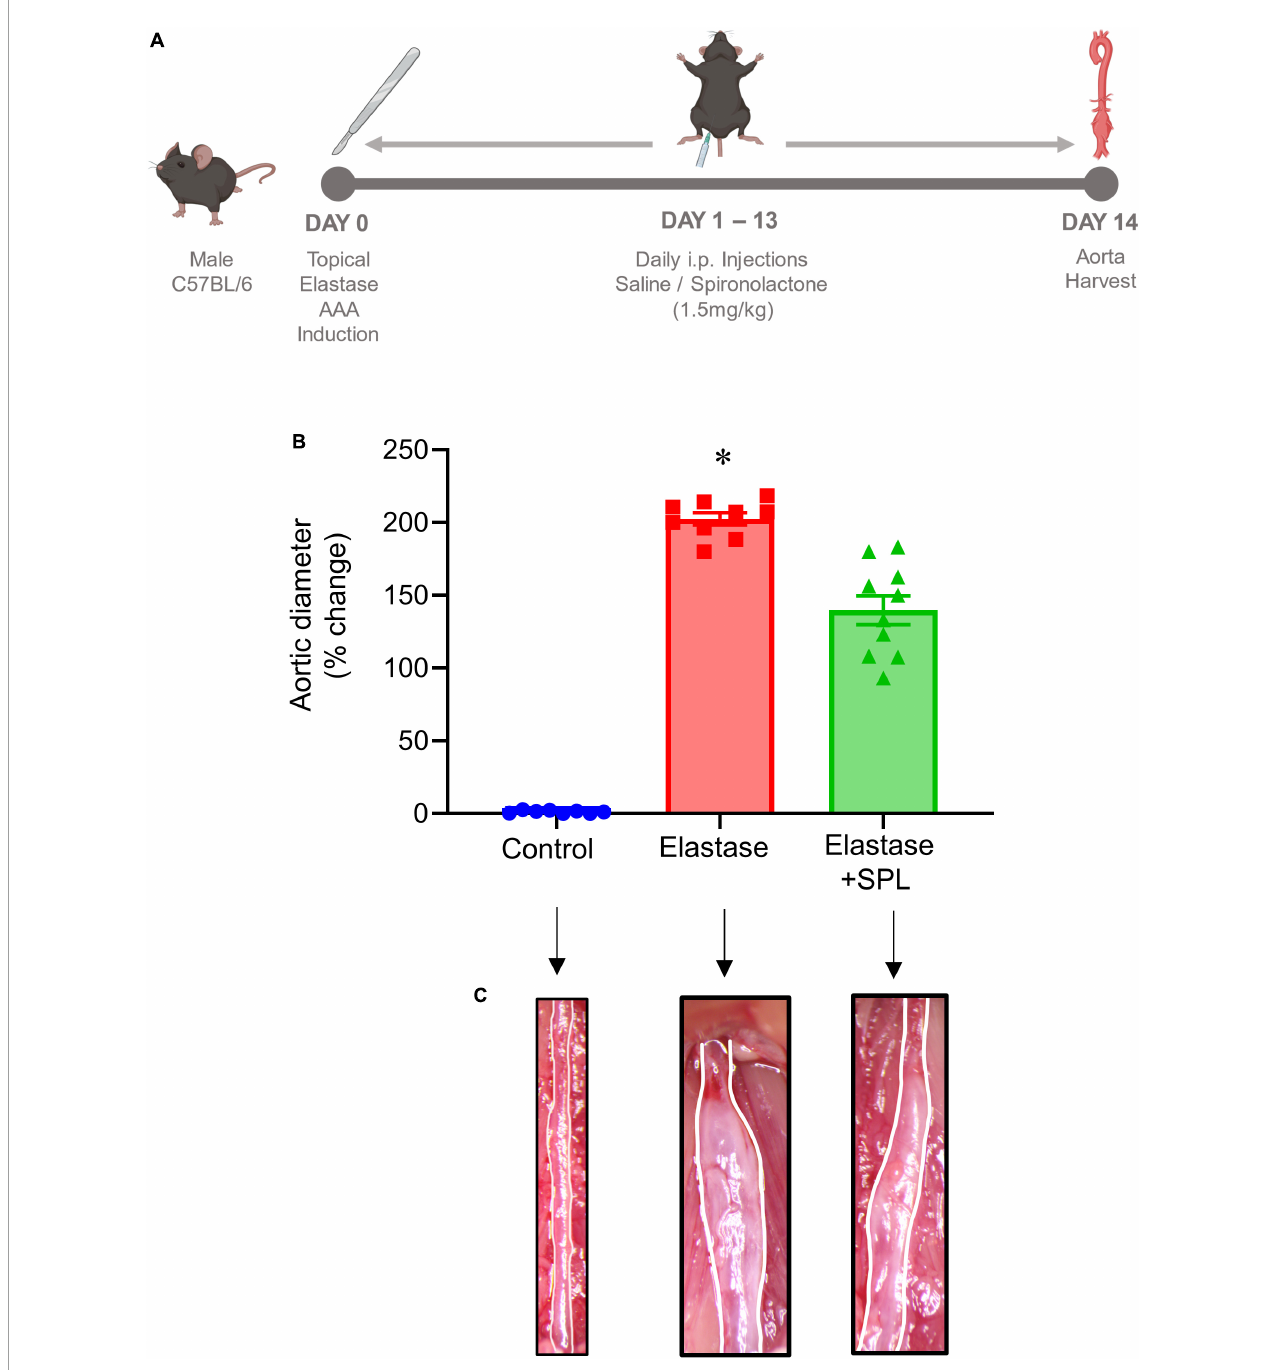
FIGURE1 Pharmacological inhibition by spironolactone decreases AAA formation in the topical elastase murine AAA model. (A) Schematic depicting the timeline and treatment protocol for spironolactone (SPL) in the topical elastase model of AAA in male C57BL/6 (WT) mice. (B) SPL treatment mitigates the increase in aortic diameter observed in elastase-treated WT mice compared to untreated mice. ∗ P < 0.0001 vs. all other groups; n = 8–10/group. (C) Representation of aortic phenotype in comparative